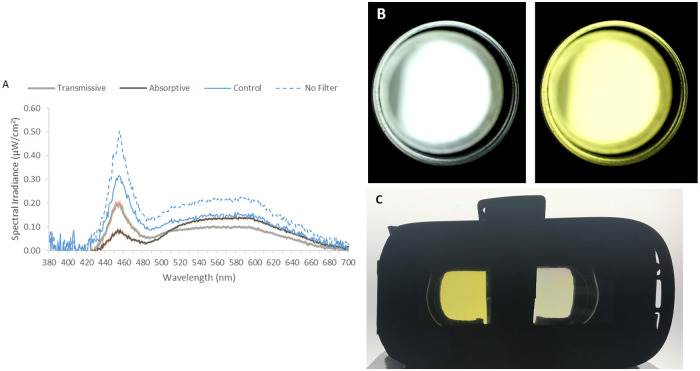
A) Averaged light spectra for the unfiltered light source (blue dashed line, no filter), light through uncoated filter (control sample, blue line), under transmissive (grey line) and absorptive (black line) states. For unfiltered light and the uncoated control filter, just one measurement was performed, while for ECFs, 11 filters were measured under both states. Orange vertical lines for transmissive and absorptive states indicate standard error of the mean (SEM). B) Images of pulse light as the user perceived them with the filter in transmissive and absorptive states. Estimated RGB values: transmissive (188,192,188), colored (219, 210, 102). C) Filters binocularly implemented in a commercial virtual reality case that participants wore for color naming tests. In the photograph, left filter is in the transmissive state and right filter is in the absorptive state. During actual experiments, both ECFs were in the same state.